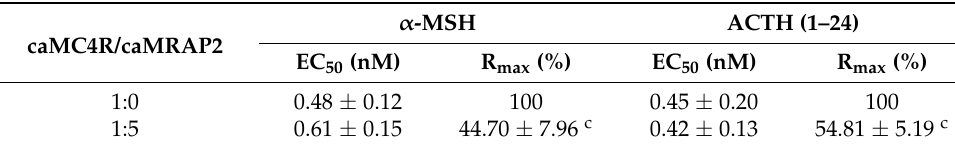
Figure 11. Effects of caMRAP2 on signaling properties of caMC4R. HEK293T cells were co-transfected with caMC4R/caMRAP2 in four different ratios (1:0, 1:1, 1:3, and 1:5), and cAMP levels under basal ( A ) or stimulated with 10 − 5 M α -MSH or 10 − 6 M ACTH (1–24) ( B , C ) were measured. The results were calculated as a percentage of 1:0 group. Results were expressed as mean ± SEM ( n ≥ 3). Different letters indicate significant difference (one-way ANOVA followed by Tukey-test). ( D , E ) The curves represented at least three independent experiments in which different concentrations of α -MSH or ACTH (1–24) were used to stimulate cells co-transfected with caMC4R and caMRAP2 at the ratios of 1:0 and 1:5. Table 4. The effect of caMRAP2 on signaling properties of